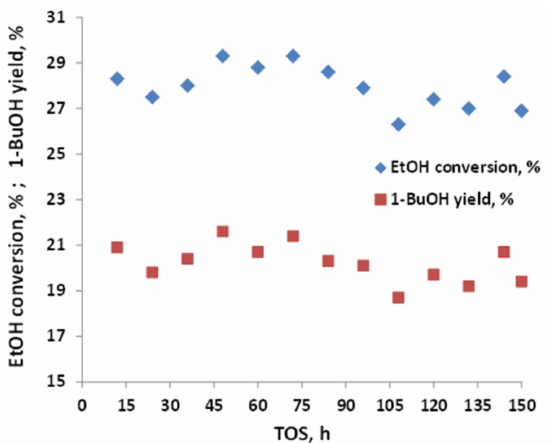
Figure 10. Ethanol conversion and 1-butanol yield measured with C-HAP-30% SiO 2 ; T = 400 ◦ C, WHSV = 0.8 h − 1 .